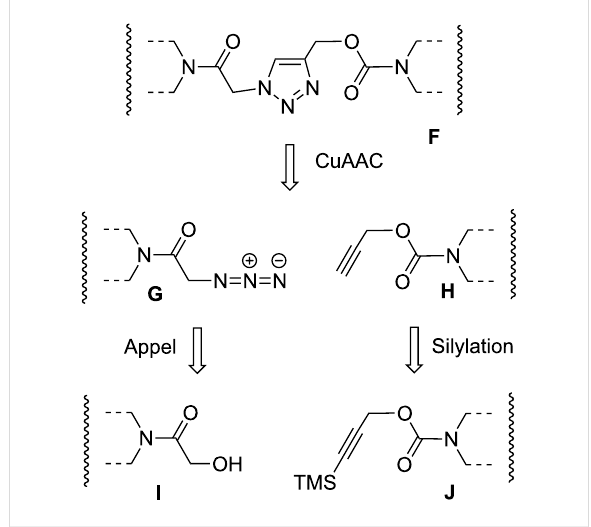
Figure 3: Synthetic strategy towards articulated